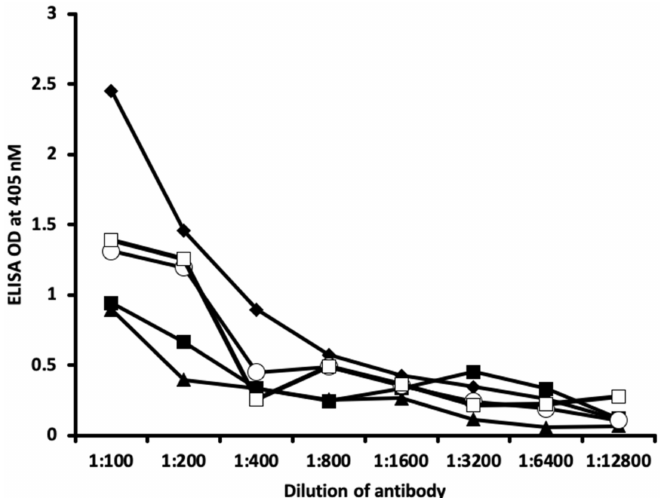
Figure 5. Reaction of di ff erent dilutions of thyroid antibodies with the same concentration of haptenic chemical-coated plates. Note that in proportion to the antibody dilution, a significant decline in the reaction of the antibodies to the haptenic chemicals was observed. (cid:7) = thyroid-stimulating hormone receptor (TSH-R) antibody to isocyanate-HSA; (cid:4) = TSH-R antibody to aflatoxin-HSA; (cid:78) = TSH-R = thyroxine deiodinase antibody to aflatoxin-HSA; (cid:3) = thyroxine antibody to formaldehyde-HSA; (cid:35) deiodinase antibody to formaldehyde-HSA.